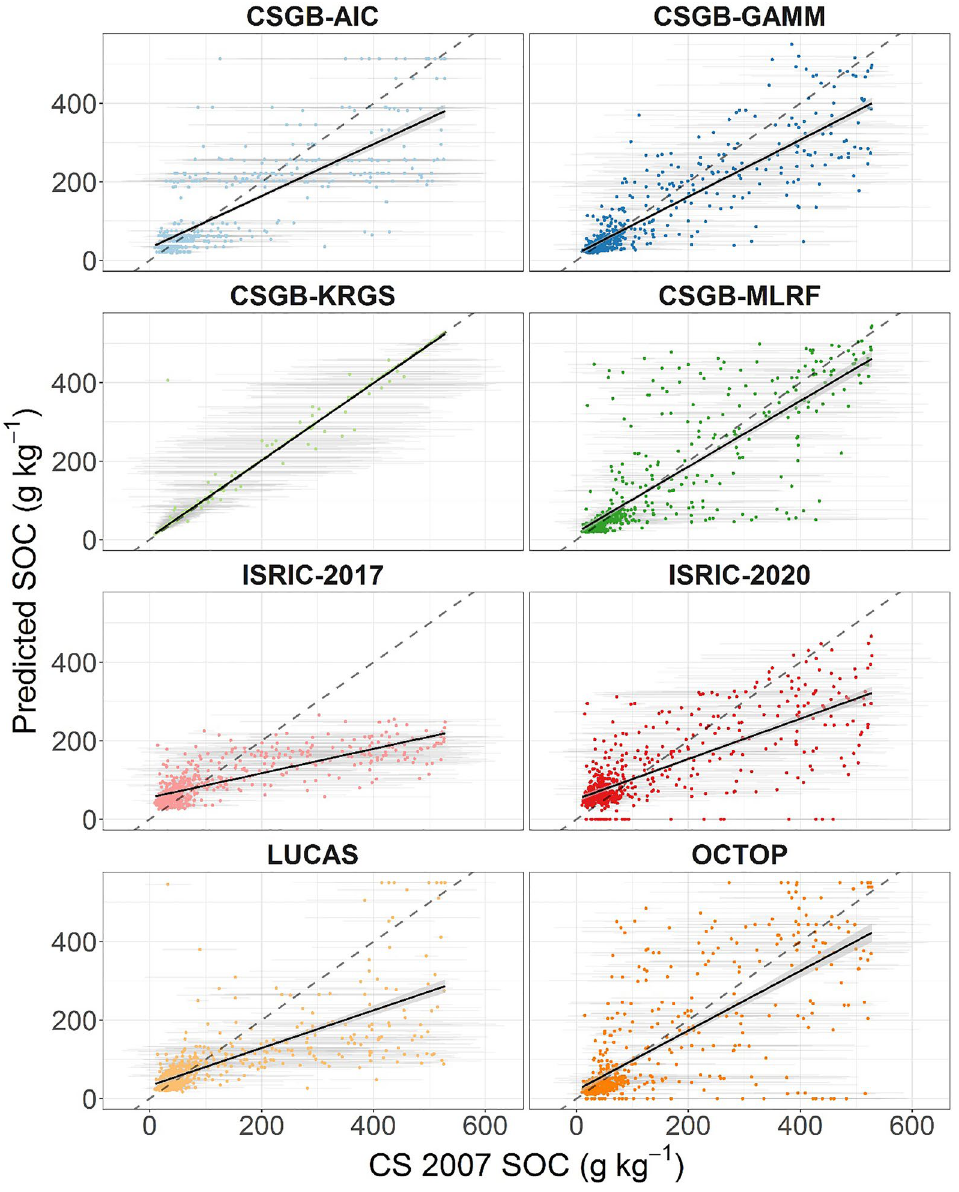
Figure 3. Predicted topsoil SOC concentrations versus measurements from the 2007 Countryside Survey (CS 2007) illustrated by scatter plots with 1:1 line (dashed) and best-fit linear model in black with grey shading representing ± 1 standard error of the mean. Grey horizontal lines around the points represent ± 1 standard error of the mean of the CS 2007 SOC